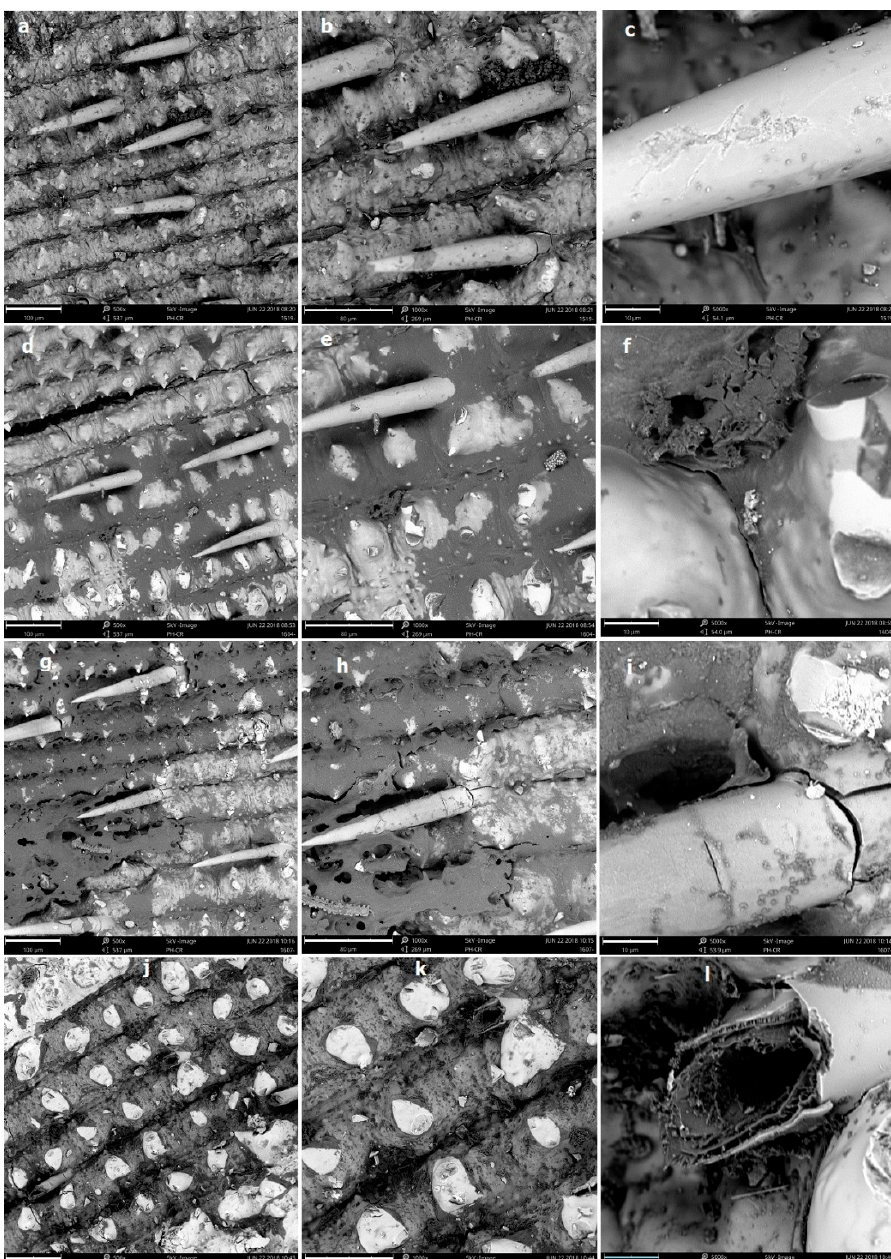
Figure 4. SEM images for untreated ( a – c ) and pretreated RD (140 °C_20 min ( d – f ), 160 °C_20 min ( g – i ), 180 °C_20 min ( j – l )). 3adgj (magnification = 500 and bar = 100 µm), 3behk (magnification = 100 and bar = 80 µm), 3cfil (magnification = 5000 and bar = 10 µm).